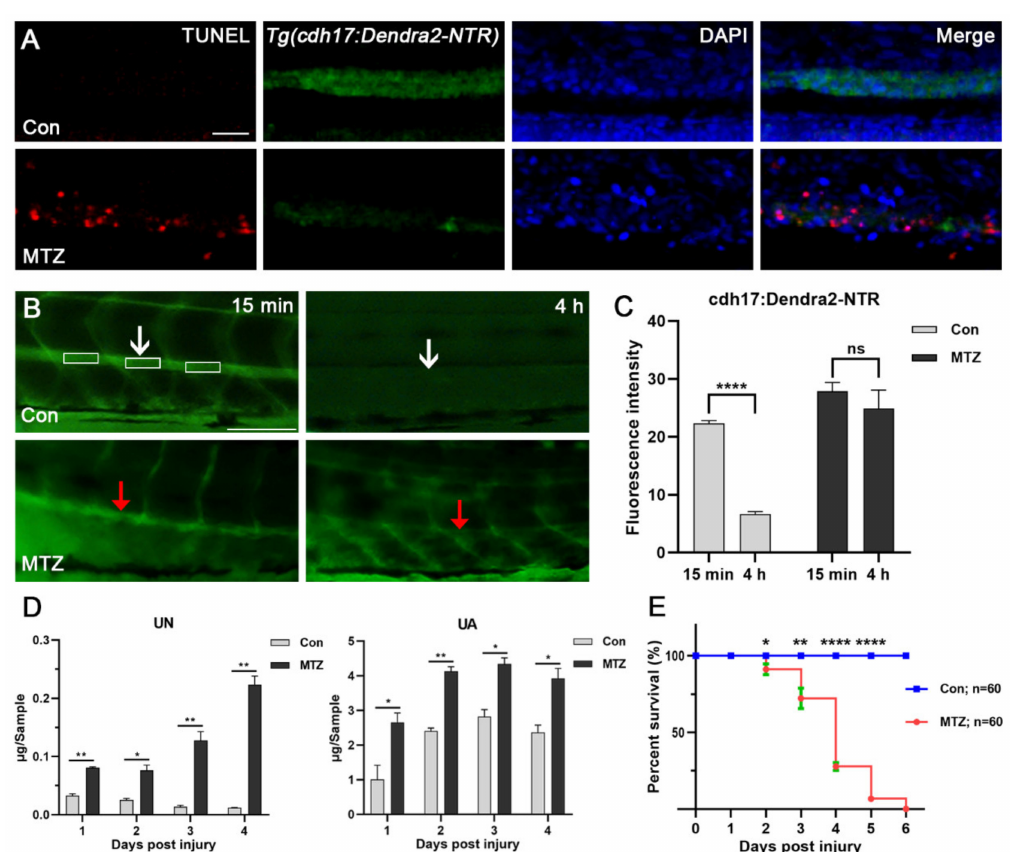
Figure 3. Renal tubular injury leads to loss of renal function. ( A ) Terminal deoxynucleotidyl transferase-mediated de- oxyuridine triphosphate nick end labeling (TUNEL)-positive apoptotic cells (red) were detected in the renal tubules of Tg(cdh17:Dendra2-NTR) zebrafish larvae treated with MTZ, but not in the control ( n = 30). Scale bar: 50 µ m. ( B , C ) Tg(cdh17:Dendra2-NTR) zebrafish larvae treated with MTZ or the control were injected with 2 nL 5% FITC-inulin, and FITC-inulin fluorescence intensity of the caudal artery was detected in three separate regions 15 min and 4 h after injection. White or red arrows respectively indicated the same measuring position of Con larvae or MTZ larvae. ( D ) Zebrafish larvae treated with MTZ or control zebrafish larvae (30 larvae/Sample) were collected at 1 dpi to 4 dpi for the detection of UA and UN. ( E ) Tg(cdh17:Dendra2-NTR) zebrafish larvae treated with MTZ and control zebrafish larvae were collected ( n = 60, respectively), and their survival rate was calculated from 1 dpi to 6 dpi. The data are expressed as the mean ± SEM; * p < 0.05, ** p < 0.01, and **** p < 0.001 (ANOVA/Dunnett’s